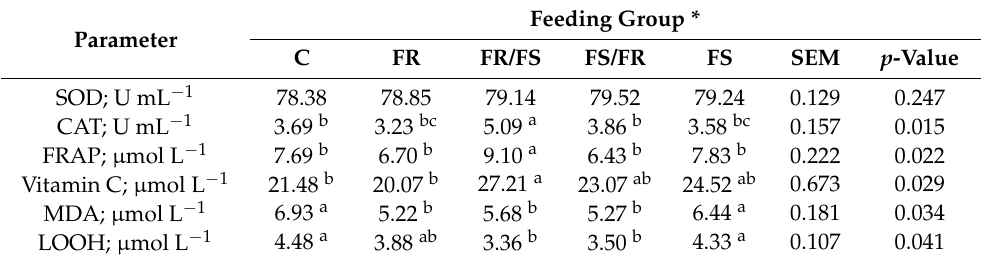
Table 4. Effect of fermented components on redox status parameters of the blood plasma of piglets. Feeding Group * Parameter C FR FR/FS FS/FR FS